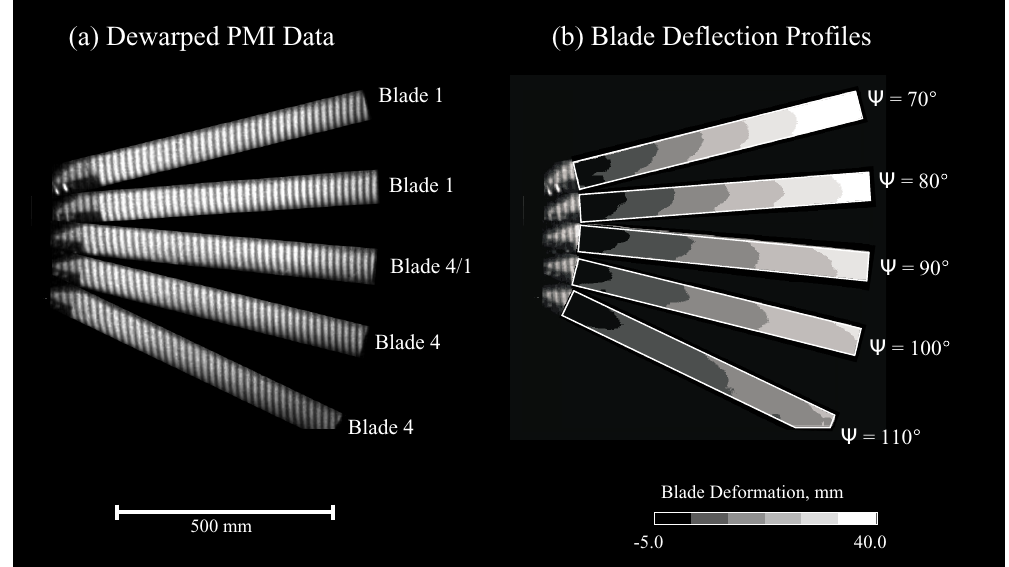
Fig. 18. Azimuth dependent PMI data and measured blade deformation profiles, C425, fuselage down. Rotor shaft angle was set to − 3